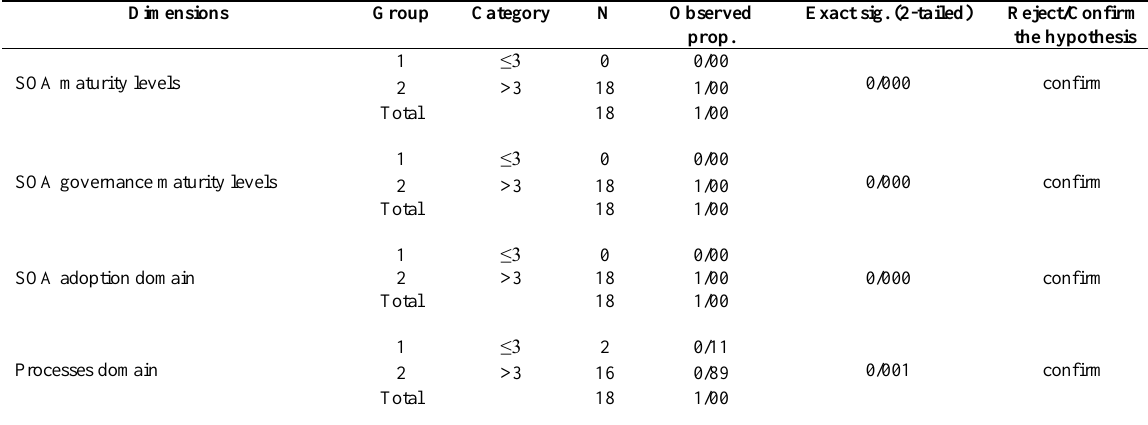
Table 6: Result of testing hypothesis of A section (sig. level 0.05)